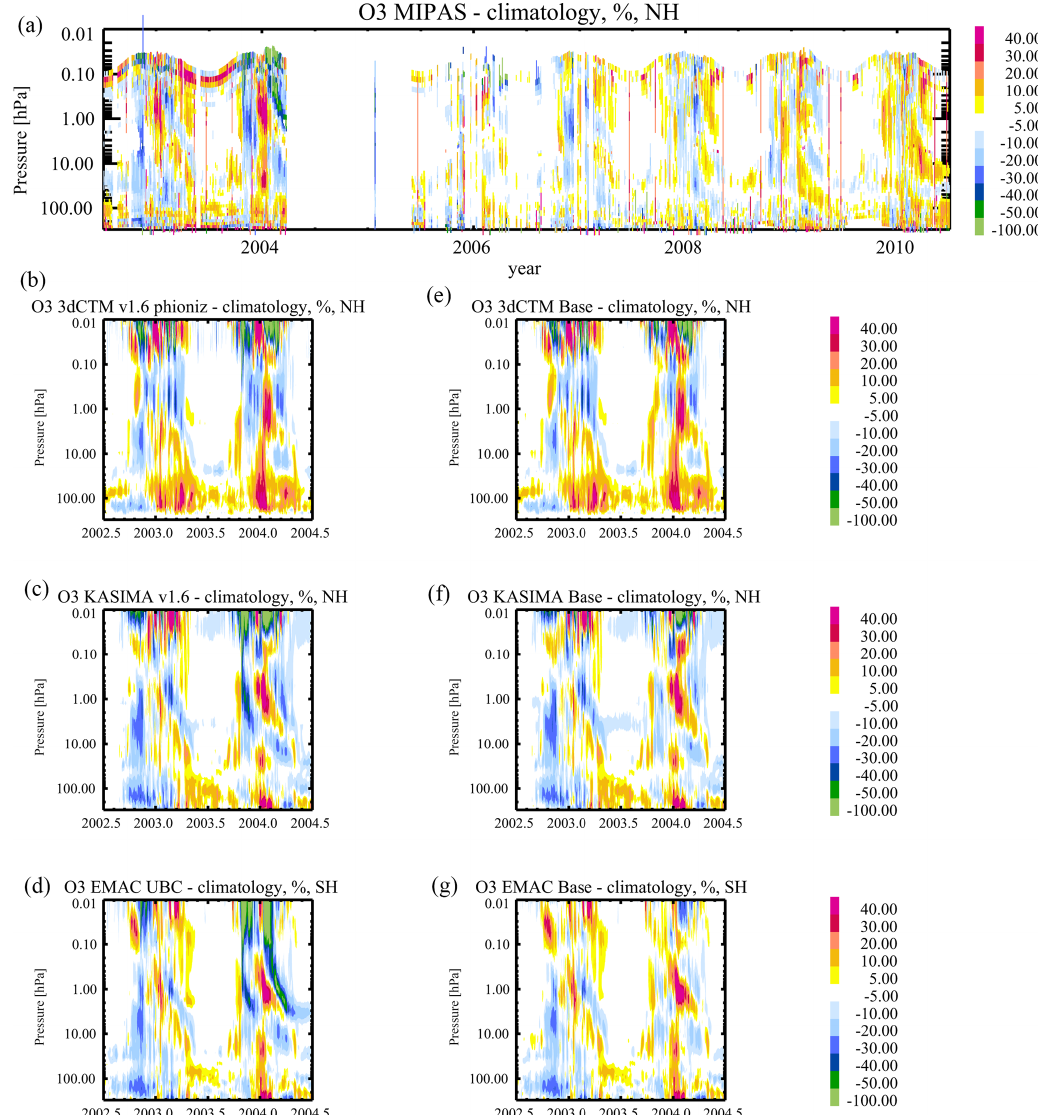
Figure 11. (a) Relative anomalies of MIPAS O 3 compared to a daily climatology derived from the 2006–2009 mean (%; see text) for high southern latitudes (70–90 ◦ N) for the period 2002–mid-2010. (b–g) Relative anomalies for the model results, calculated in the same way for mid-2002 to mid-2004. Left: model runs including particle impact; right: model runs without particle impacts. From top to bottom: 3dCTM, KASIMA and